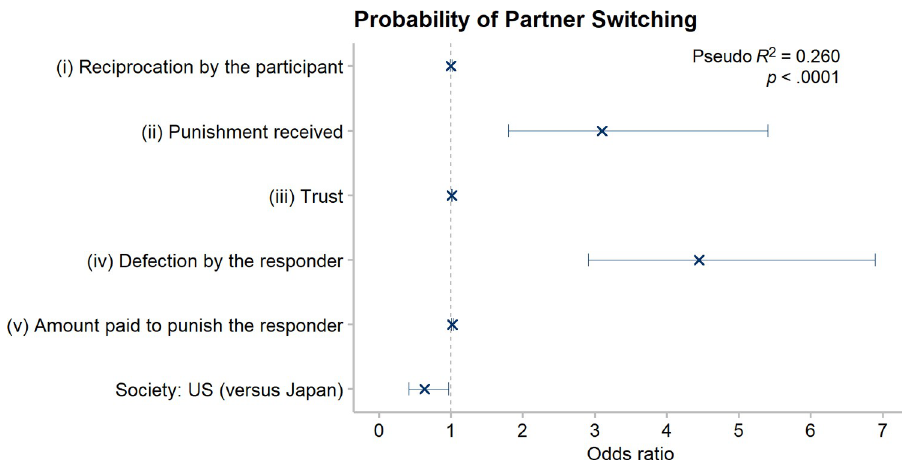
Fig 2. Adjusted odds ratio of each predictor for the decision to switch partners. Estimates of how much each predictor affected the decision to switch partners, when controlling for the five others. An odds ratio greater than 1 indicates a greater likelihood of partner switching; an odds ratio less than 1 indicates a lower probability of partner switching. Bars are 95% confidence intervals. Reciprocation by the participant = percent of 3P that the participant returned to the truster (0–100%). Punishment by the partner = whether the truster punished the participant’s response (1, 0). Trust = P, the number of points the participant sent to the responder (0–100). Defection by the responder = the responder defected or reciprocated on the participant (1, 0). Amount paid to punish the responder = number of points the participant paid to punish the responder